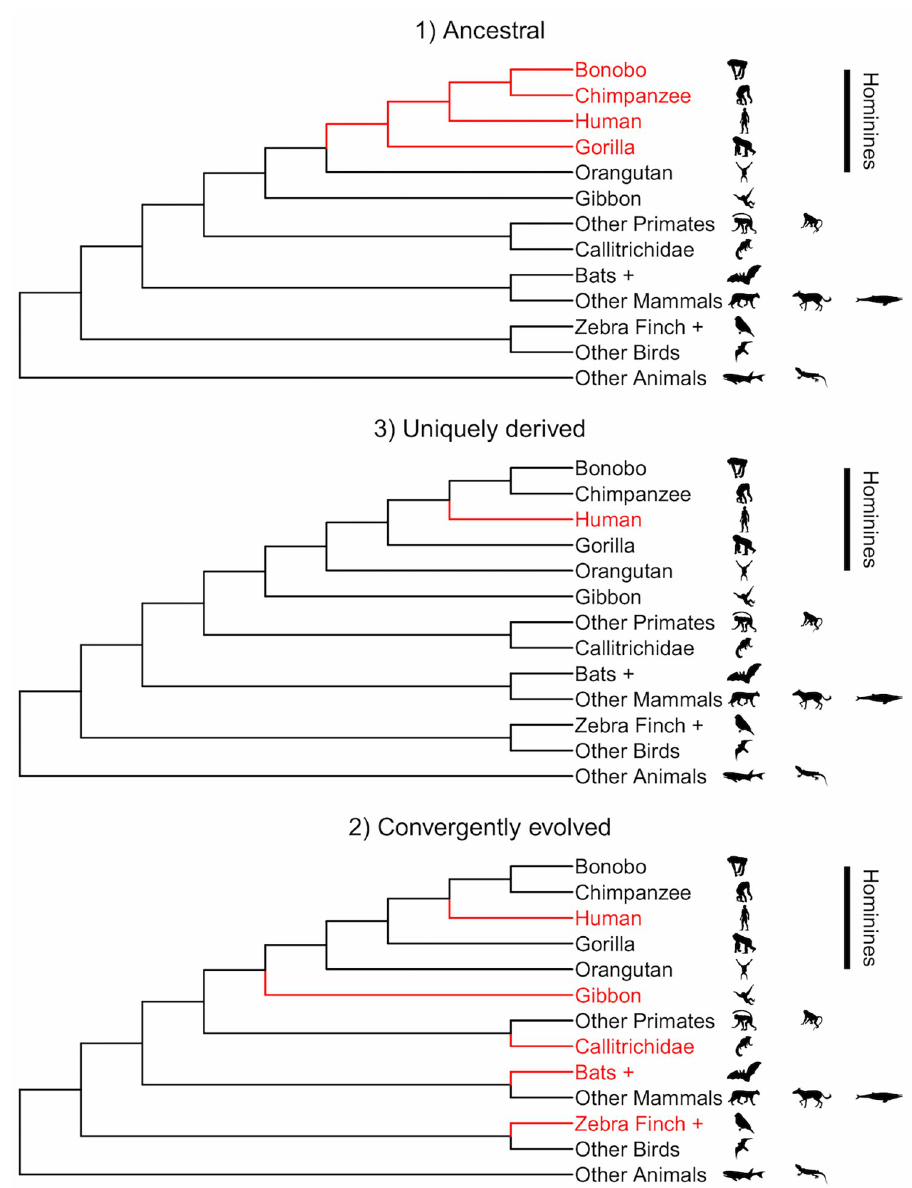
Fig 1. Evolutionary pathways of CDC. A feature such as CDC with the function of aiding the acquisition of communicative competence can be (1) ancestral: homologously derived among African great apes and thus also found in humans; (2) unique among the great apes but convergently shared analogously with other, more distantly related species; or (3) newly evolved within our own species. Red represents the presence of IDC features. Outline credits : Human : T . Michael Keesey; Chimpanzee : Jonathan Lawley; Bonobo : T . Michael Keesey; Gorilla : T . Michael Keesey (after Colin M . L . Burnett); Orangutan : Gareth Monger; Gibbon : Kai R . Caspar; Tamarin : Yan Wong and T . F . Zimmerman; Zebra Finch : Jim Bendon (photography) and T . Michael Keesey (vectorization); Bat : Yan Wong; Squamate : Ghedo and T . Michael Keesey; Feline : Margot Michaud; Equine : T . Michael Keesey; Cetacean : Scott Hartman; Falcon : Liftarn; Fish , macaque and baboon are uncredited . Link to creative commons license: https://creativecommons.org/licenses/by-sa/3. 0. Link to public domain license: https://creativecommons.org/publicdomain/zero/1.0. Outlines were downloaded from http://www.http://phylopic.org. The layout of the figure was achieved in R (version 4.1.2, R Development Core Team, 2012). C AU : AbbreviationlistshavebeencompiledforthoseusedthroughoutFigs 1 and 2 : Pleaseverifythatallentriesarecorrect : DC, child-directed communication; IDC, immature-directed communication.